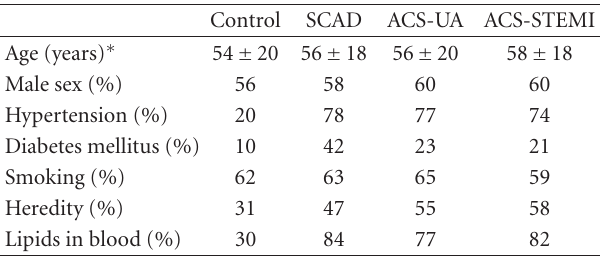
Table 1: Clinical characteristics of investigated groups.